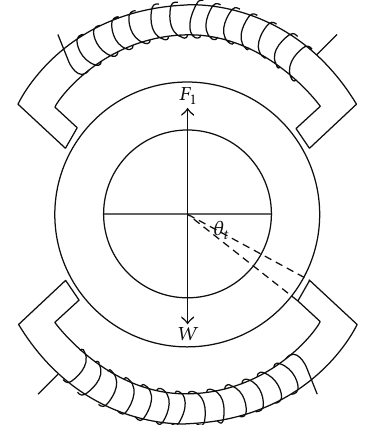
Figure 1: A shaft and a pair of